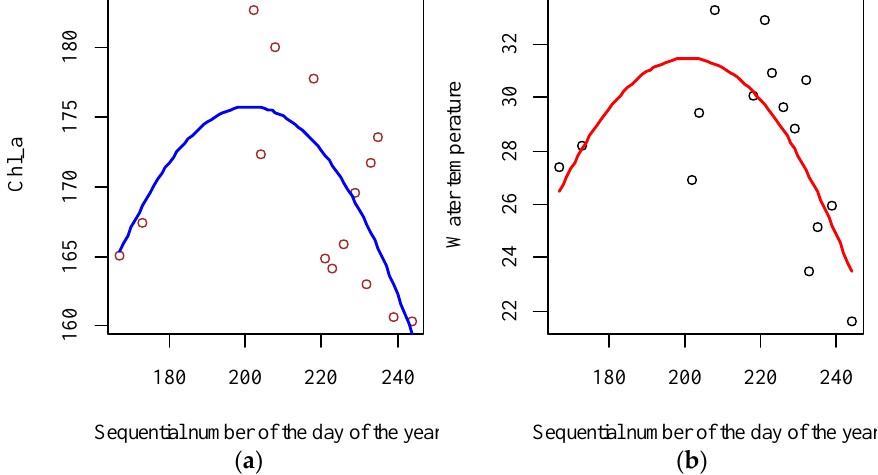
Figure 3. Seasonal course of chlorophyll-a concentration and water temperatures (°C) from day 167 to day 244 of the year: ( a ) is the chlorophyll-a (mg/m3) (brown circles) and the parabola that approximates the trend (blue line): Chl_a = – 0.0089 Order 2 + 3.59 Order – 185.2, R adj2 = 0.40; ( b ) is the water temperature (°C) (black circles) and the parabola approximating the trend (red line): Chl_a = – 0.0043 Order 2 + 1.75 Oder – 143.9, R adj2 = 0.44.